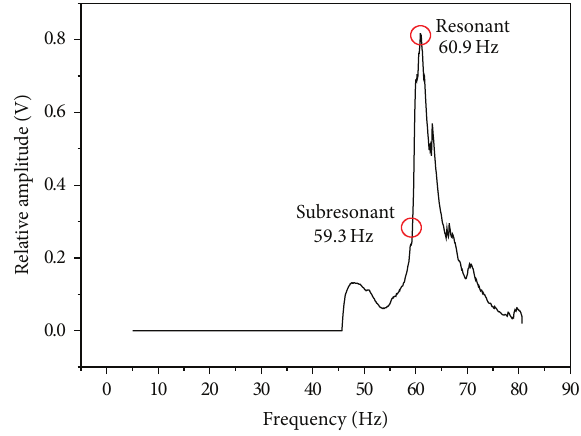
Figure 4: The spectrum map of the Meta-Lax.